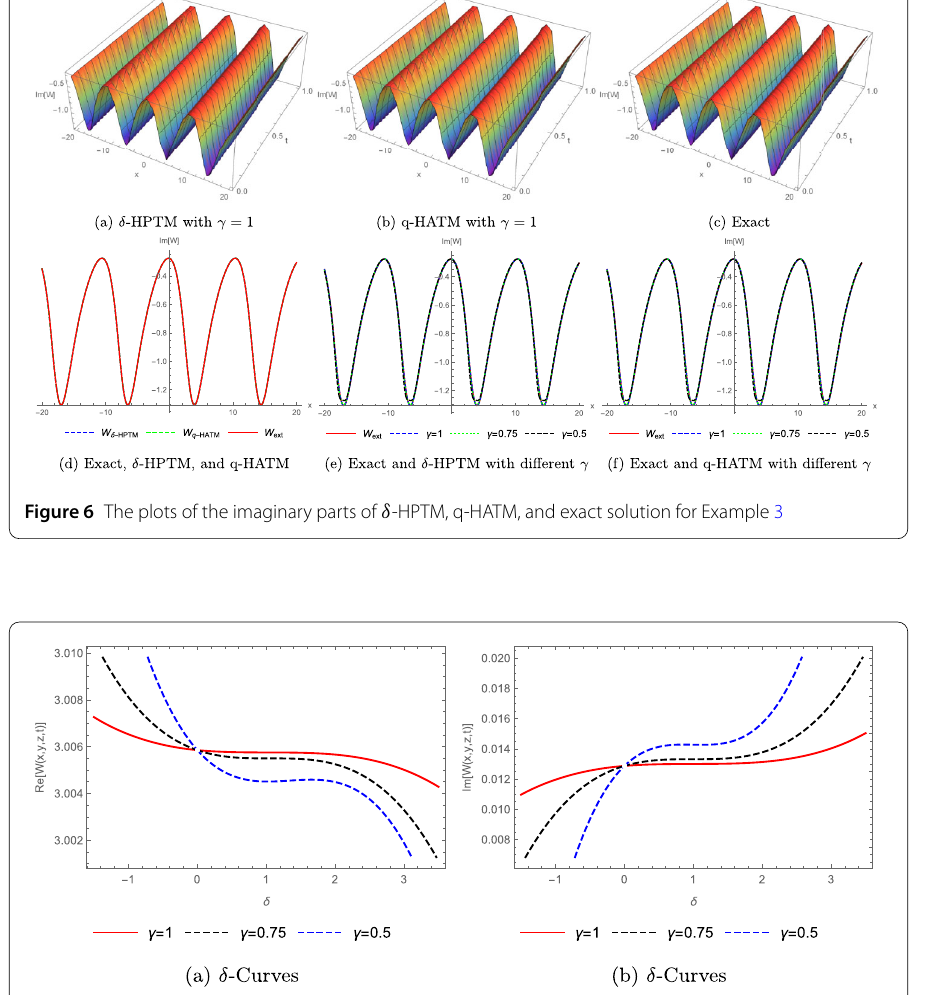
• Fig. 9: β 1 = 1, β 2 = 2, β 3 = 10, ξ = 1, e 0 = 3, p = 0.3, q = 0.3, z = y = 2, n = 1, x = 1 , and t = 0.5